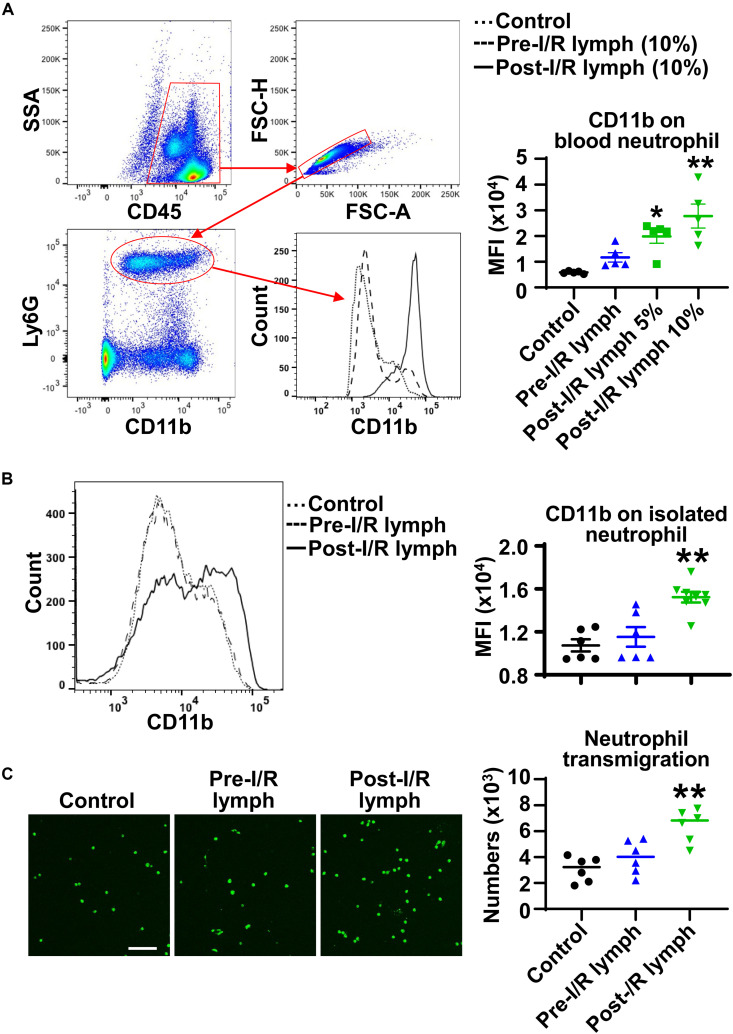
Post-I/R lymph upregulates neutrophil surface CD11b expression and facilitates neutrophil trans-endothelial migration. (A,B) Post-I/R lymph, but not pre-I/R lymph, upregulates surface CD11b expression on blood neutrophils (A) and on bone marrow derived neutrophils (B). n = 5–8/group. (C) Post-I/R lymph, but not pre-I/R lymph, promotes neutrophil trans-endothelial migration induced by recombinant CXCL1 (100 ng/mL). n = 6/group. *p < 0.05, **p < 0.01 vs. control. One-way ANOVA was used.